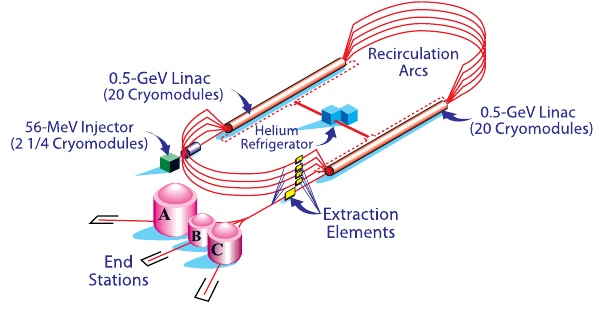
FIG. 12. Schematic of the CEBAF